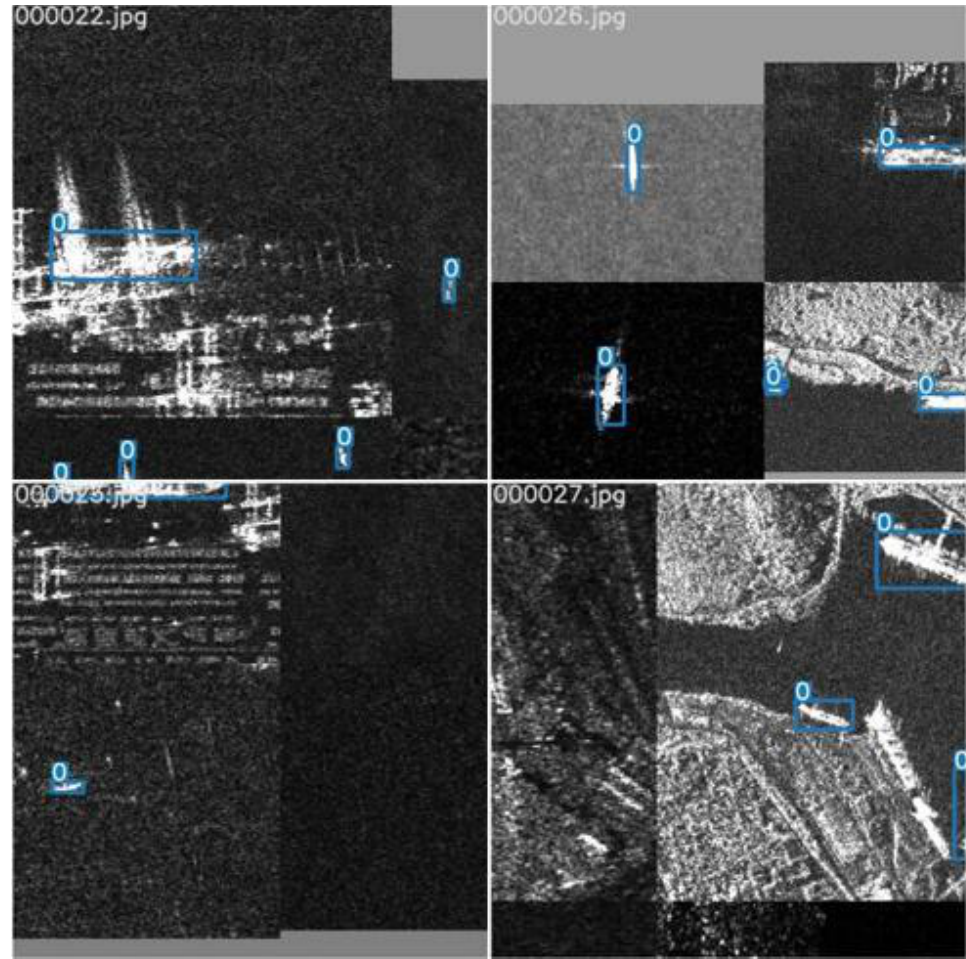
Figure 11. The effect of Mosic data